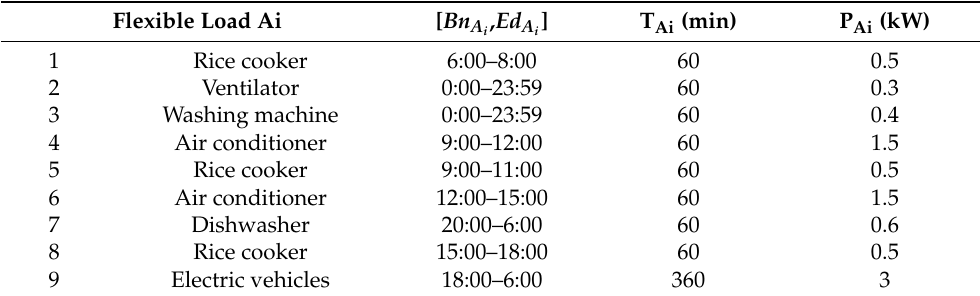
Table 1. Flexible load data on the user